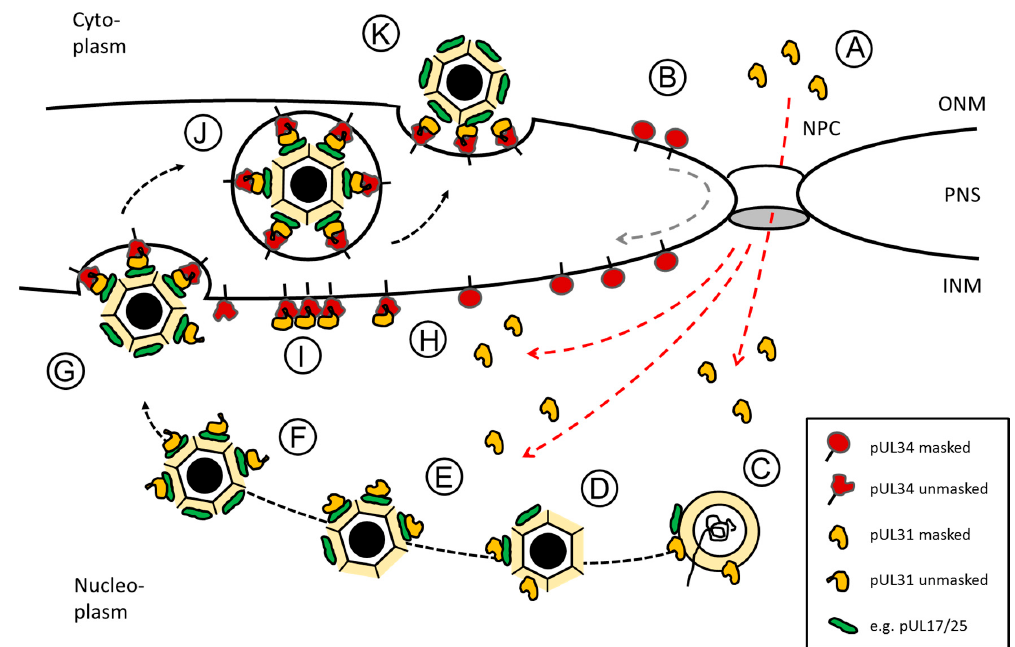
Figure 2. Herpes simplex virus type 1 (HSV1) pUL31-mediated escort of capsids from replication compartments to sites of primary envelopment. Schematic representation of the route, pUL34 and pUL31 take after their synthesis in the cytoplasm until forming the nuclear egress complex (NEC) at the inner nuclear membrane (INM): ( A ) pUL31 (red dashed lines) and ( B ) pUL34 (grey dashed line) are imported into the nucleus independent of each other. pUL34 and pUL31 are masked by conformation and/or unknown binding partners to prevent premature NEC formation. ( C , D ) In the nucleus, pUL31 associates with capsids at the sites of their assembly and potentially assists in genome packaging. ( E ) pUL31 recognizes surface components of the capsid e.g., pUL17/pUL25 that mark capsid maturation. ( F ) In presence of the N-terminal domain of pUL31, nucleocapsids are released from replication compartments with pUL31 escorting them to sites of primary envelopment. ( G ) Capsid-associated pUL31 and pUL34 integral to the INM are unmasked to form heterodimeric NECs that assemble into hexagonal lattices to curve around nucleocapsids until primary envelopment is complete. ( H ) NECs or ( I ) NEC seeds preexisting at the INM could contribute to capsid recruitment and envelopment. ( J ) Primary enveloped nucleocapsids temporarily reside in the perinuclear space (PNS). ( K ) Fusion of the primary envelope with the outer nuclear membrane (ONM) allows for release of the nucleocapsids to the cytoplasm for secondary envelopment. The nuclear pore complex (NPC), the outer nuclear membrane (ONM) and the inner nuclear membrane (INM) as well as the perinuclear space (PNS) are depicted (modified after [17] ).